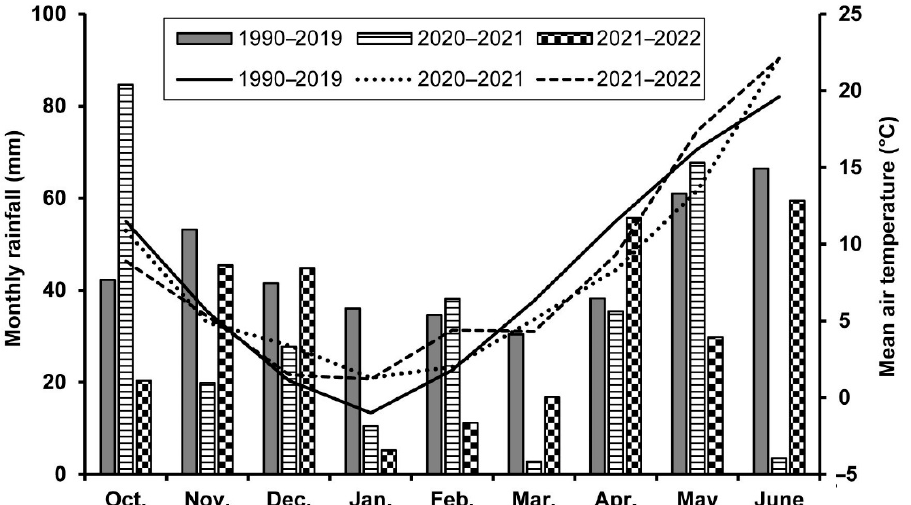
Figure 6. Monthly rainfall (columns) and mean air temperature (lines) at the experimental site of Centre for Agricultural Research (Martonv á s á r, Hungary) during the winter wheat growing season. the Centre for Agricultural Research (Martonvásár, Hungary) during the winter wheat growing Long-term (1990–2019) average is displayed for season. Long-term (1990–2019) average is displayed for reference.